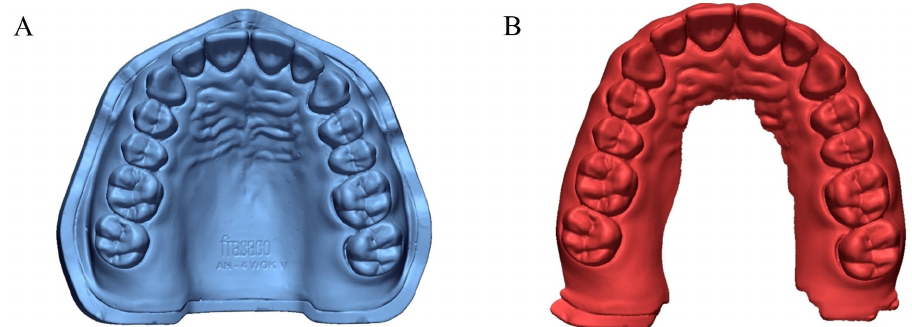
Figure 1. Virtual models. ( A ) CAD reference model (CRM). ( B ) CAD test model (CTM).